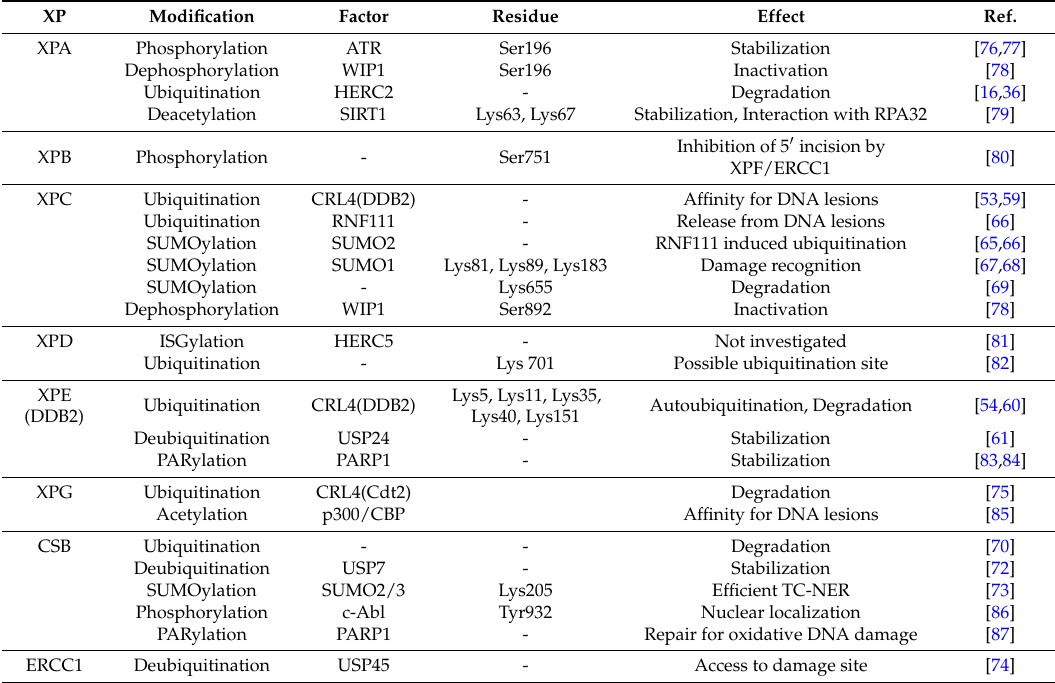
Table 2. A summary of posttranslational modification of NER